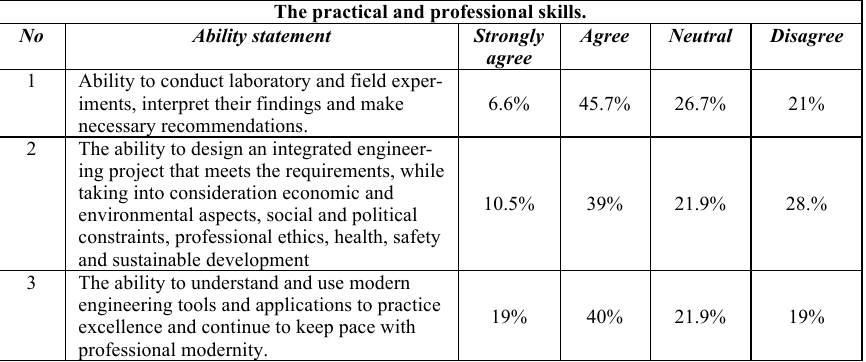
Table 3. Graduates feedback on Practical and Professional Skills learning outcomes The practical and professional skills.